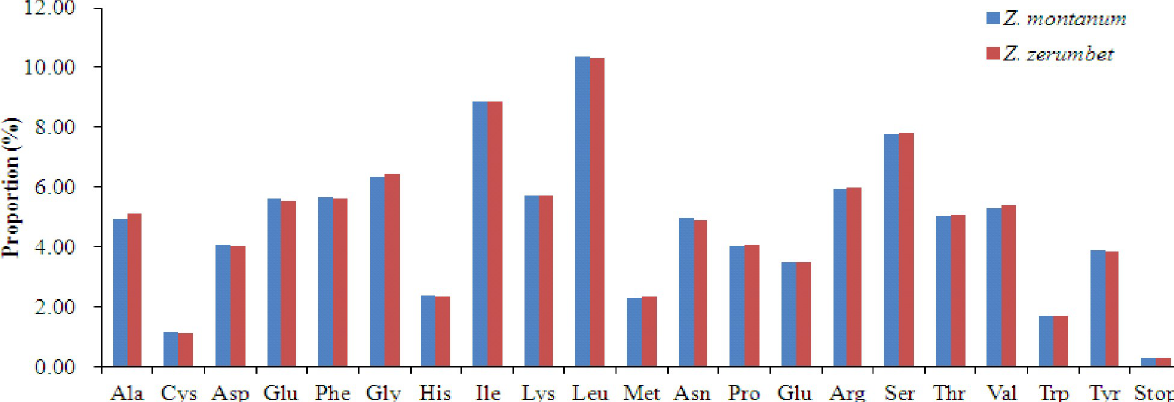
Fig 2. Amino acid proportion in Z . montanum and Z . zerumbet protein-coding sequences.